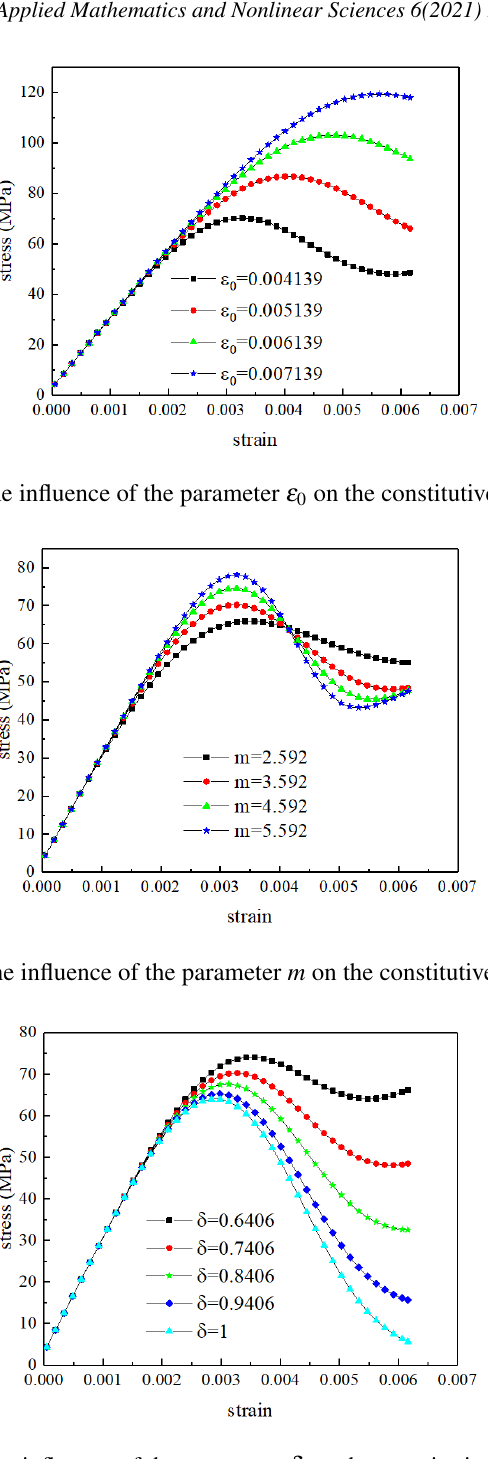
Fig. 7 The influence of the parameter δ on the constitutive